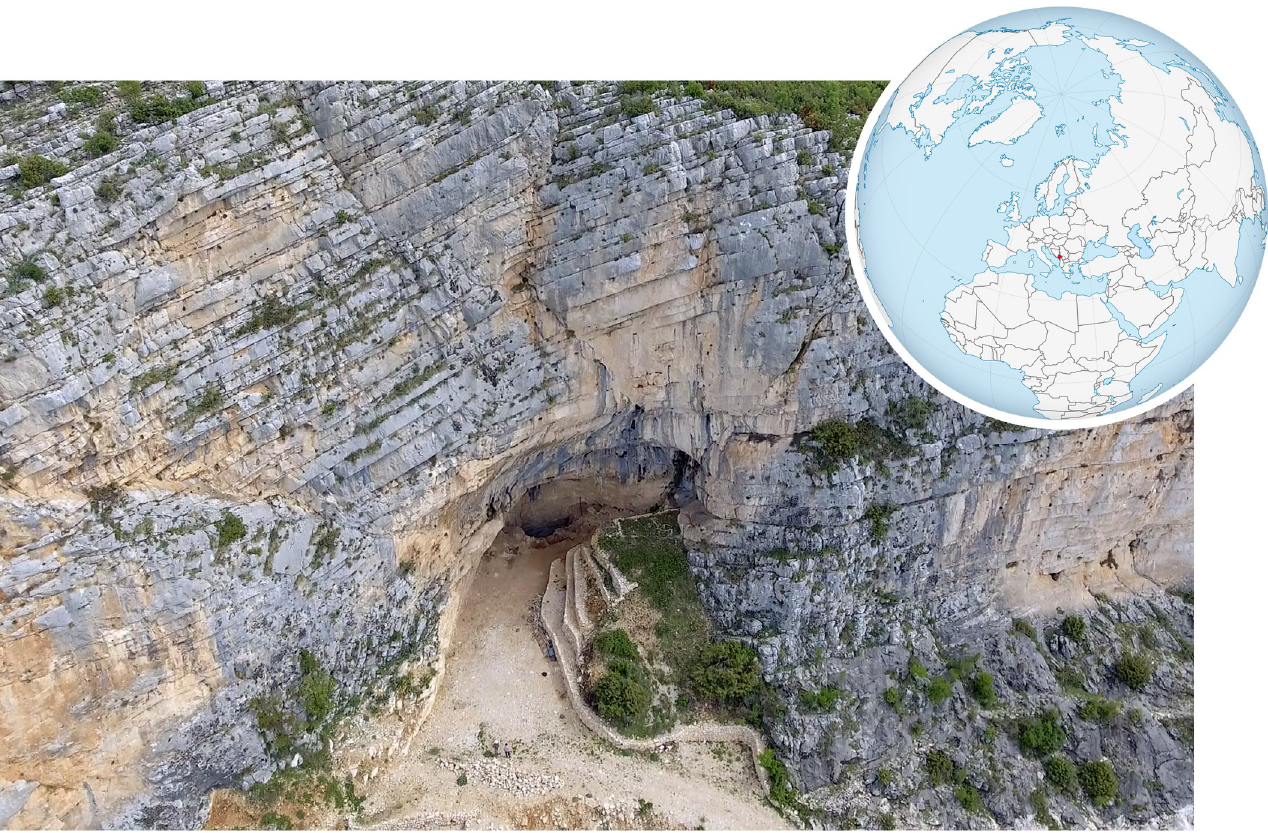
Fig 11. The rockshelter of Crvena Stijena. The site exists in a cliff that overlooks the Trebisˇnjica River. Photograph by project members Colin McFadden and Samantha Porter. World orthographic projection shared via Wikimedia Commons with a Creative Commons license.